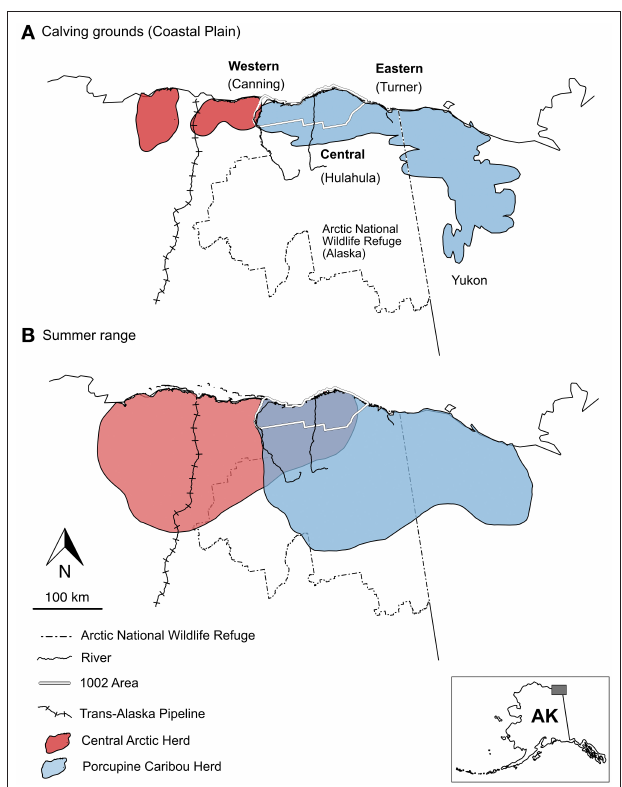
FIGURE 1 | Seasonal ranges for caribou of the Arctic National Wildlife Refuge, AK. Ranges of the Central Arctic (red) and Porcupine Herds (blue) are distinct during (A) calving periods, but there is greater spatial overlap across their (B) summer ranges. Antler surveys were conducted along the Coastal Plain calving grounds, accessed by major river systems; Canning River (Western Coastal Plain), Hulahula River (Central Coastal Plain), and Turner River (Eastern Coastal Plain). The Trans-Alaska Pipeline (cross-hatched line) was completed in 1977. Herd range boundaries from Trammell et al.